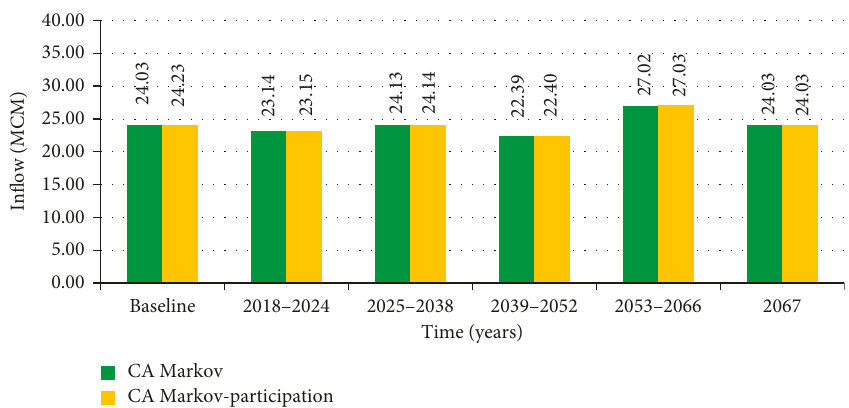
Figure 19: Baseline and future yearly runoff into Huay Ling Jone